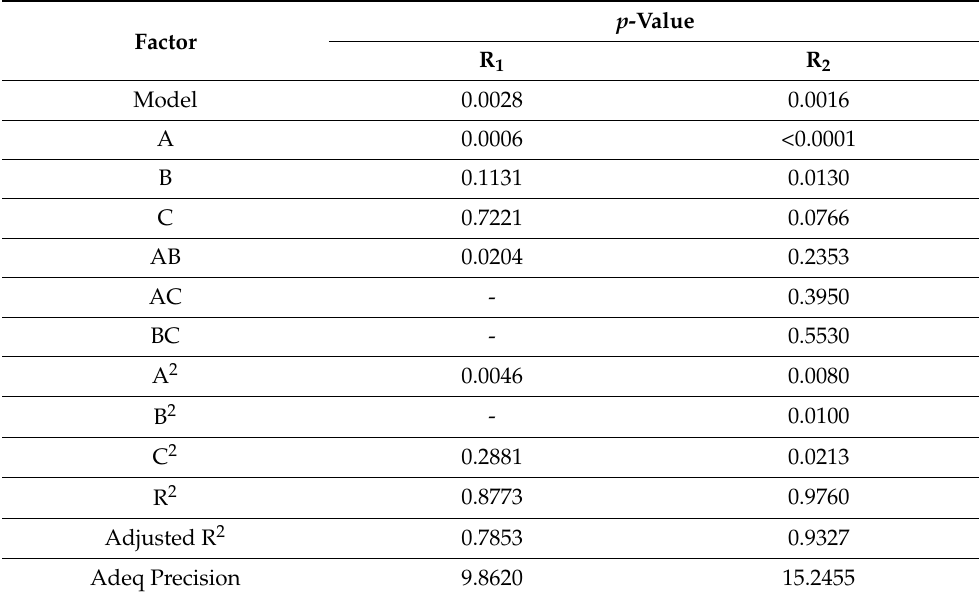
Table 5. Significance of each factor equation model terms of the TYR- β CD/CS